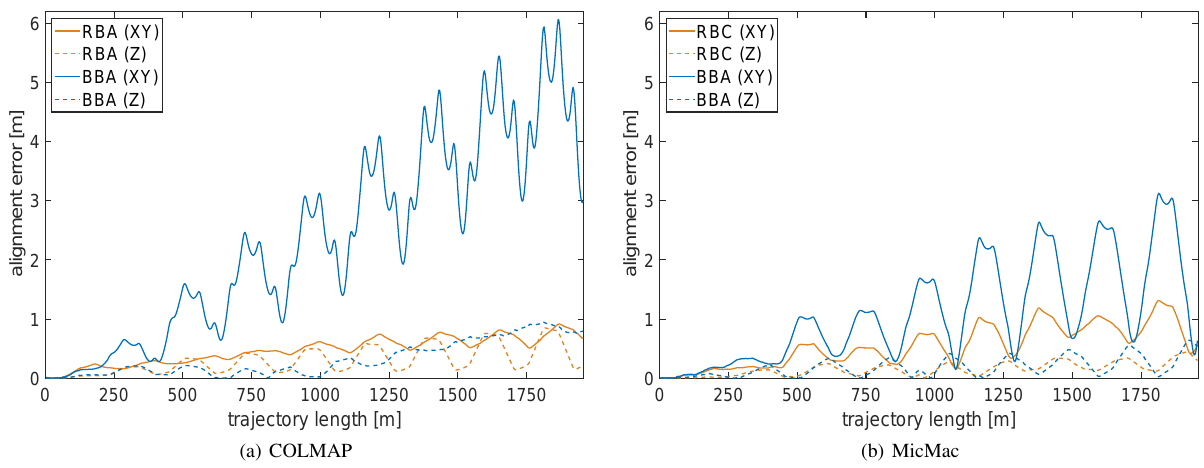
Figure 6. Results of the experiments for the Ladybug dataset. Distances between estimated camera poses and ground truth trajectory, produced (a) by COLMAP and (b) by MicMac. Solid lines show the planimetric residuals, while dashed lines show the altimetric component.